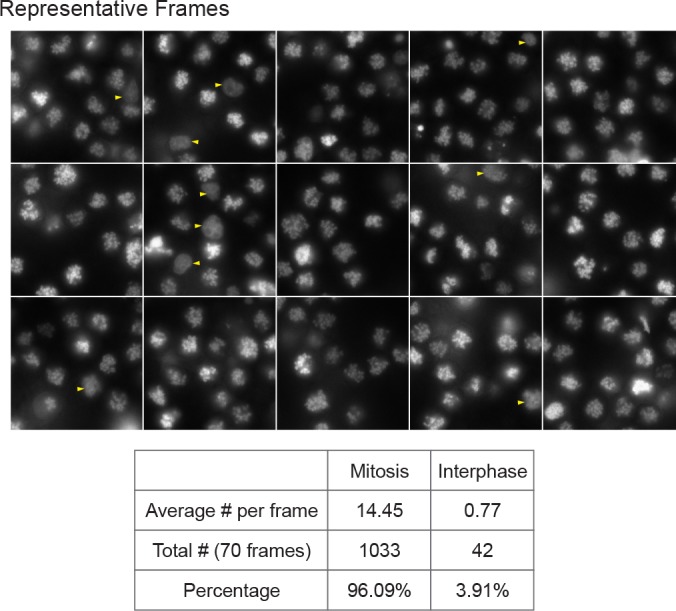
Synchronization for mitotic cells.Cultured mESCs were treated with 100 ng/mL of Nocodazole for 6 hr, and mitotic cells were collected by shake off. The collected cells were imaged for H2B-GFP in 70 frames, with 15 representative frames shown. Each cell was classified as mitotic or interphase. Interphase cells are marked with yellow arrowheads. The average cell number per frame, the total cell count in 70 frames, and percentage for mitotic and interphase cells are shown in the table.